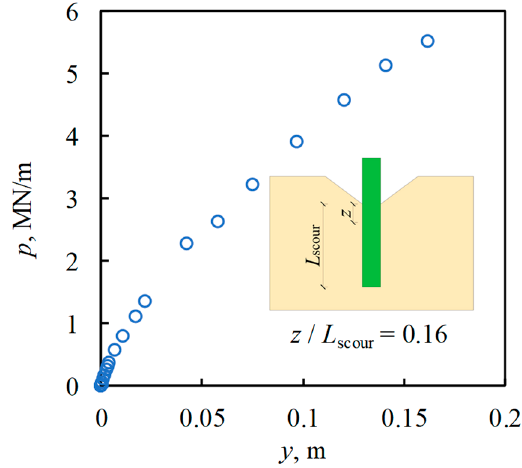
Figure 8. A p ‒ y curve of the monopile with D = 3 m. Figure 8. A p-y curve of the monopile with D = 3